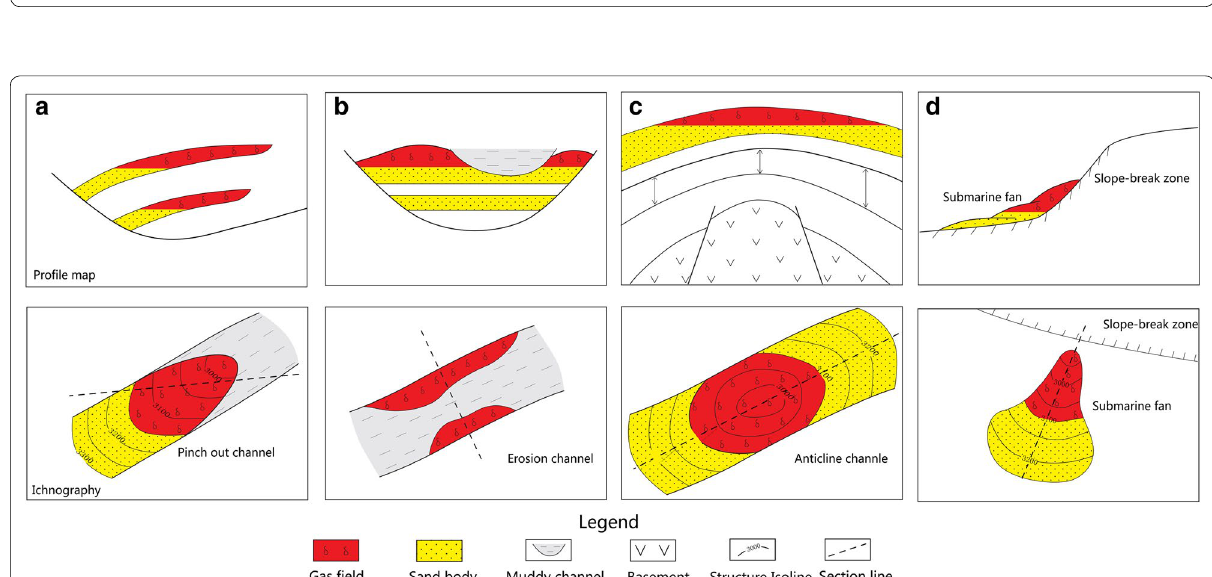
Fig. 7 The time-slice showing channelized submarine fan in slope area of the Lingshui sag in work area B, Qiongdoangnan Basin (location is shown in Fig. 1)